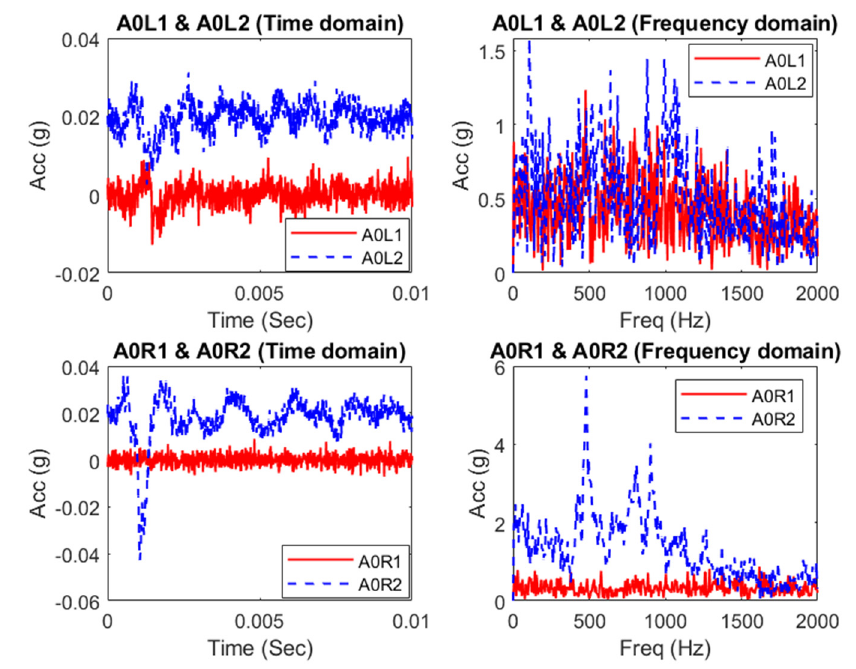
Figure 10. Captured time domain acceleration data and their frequency spectra at 0 ◦